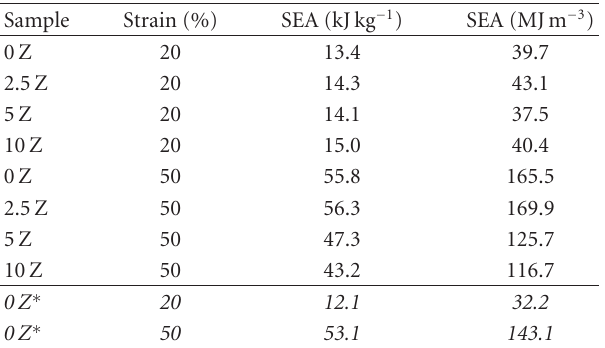
Figure 3: Microstructure of the TRIP-steel/Mg-PSZ honeycomb specimen 2.5 Z after approximately 60% engineering strain, in view of (a) cross-section with crack in the center and (b) longitudinal section (denoted by X 3 -loading direction in left upper corner). Table 2: Specific energy absorption (SEA) of the honeycomb samples at 20% and 50% compression